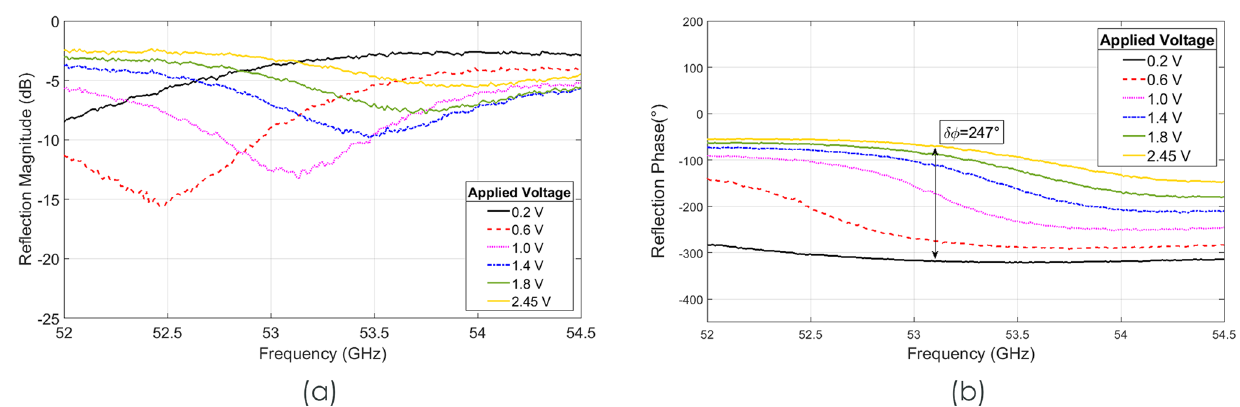
Figure 5. Measured results of the prototype unit cell ( a ) Reflection magnitude measured results with varying voltage. ( b ) Reflected phase shift simulation results of the unit cell with varying voltage